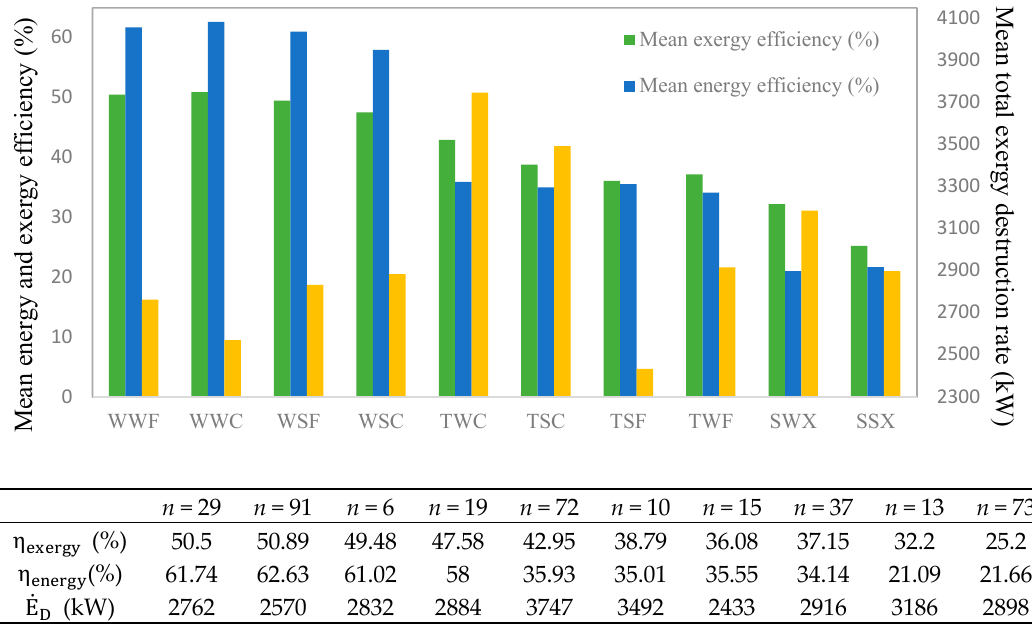
Figure 8. The mean energy and exergy efficiencies as well as the mean total exergy destruction rate of each typical day under optimization condition based on minimum total exergy destruction rate.